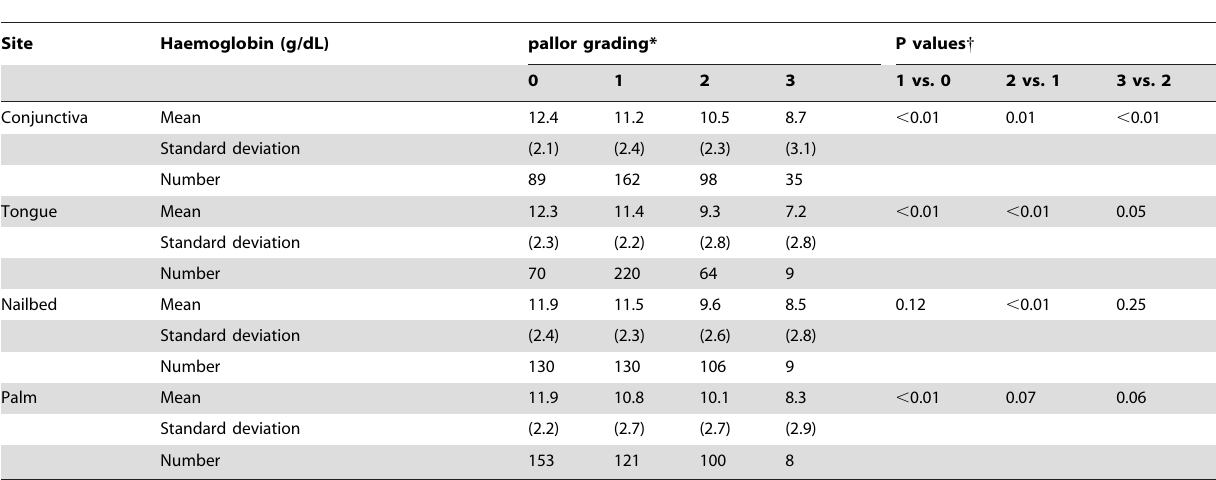
Table 1. Haemoglobin levels across pallor categories (observer 1, n